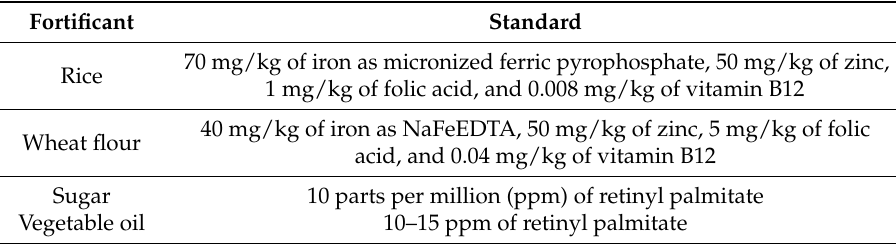
Table 1. Standards for an integrated fortification